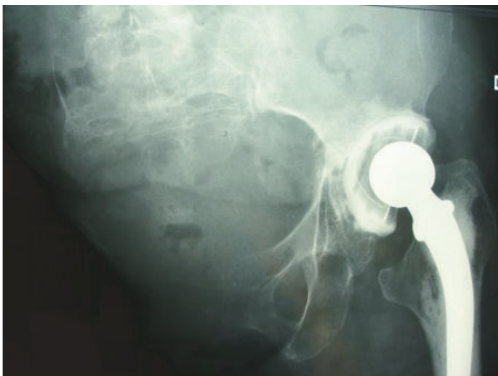
Figure 1: The radiological appearance of her right hip following previous TB, arthrodesis, subsequent lymphoma, and radiother- apy—and there is now a radiation induced sarcoma involving the right hemiplevis! Note that the left hip is normal.